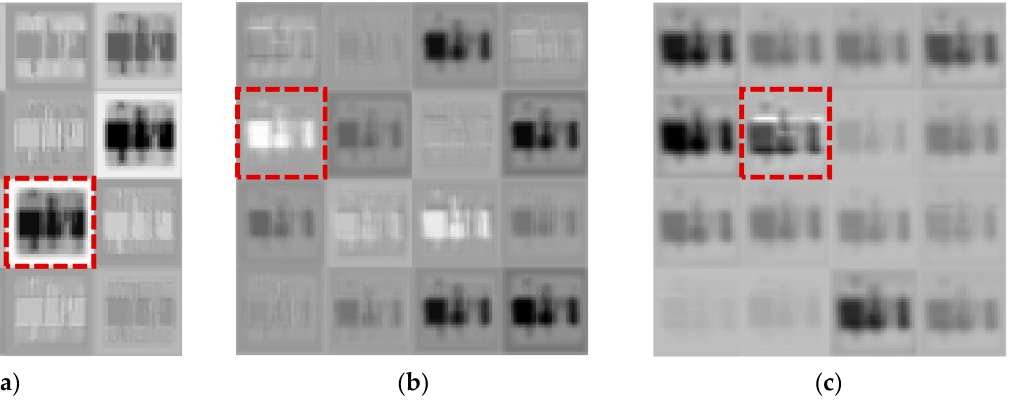
Figure 14. The 16 feature images for each convolution layer: ( a ) ConvInp; ( b ) Conv1; ( c ) Conv2.